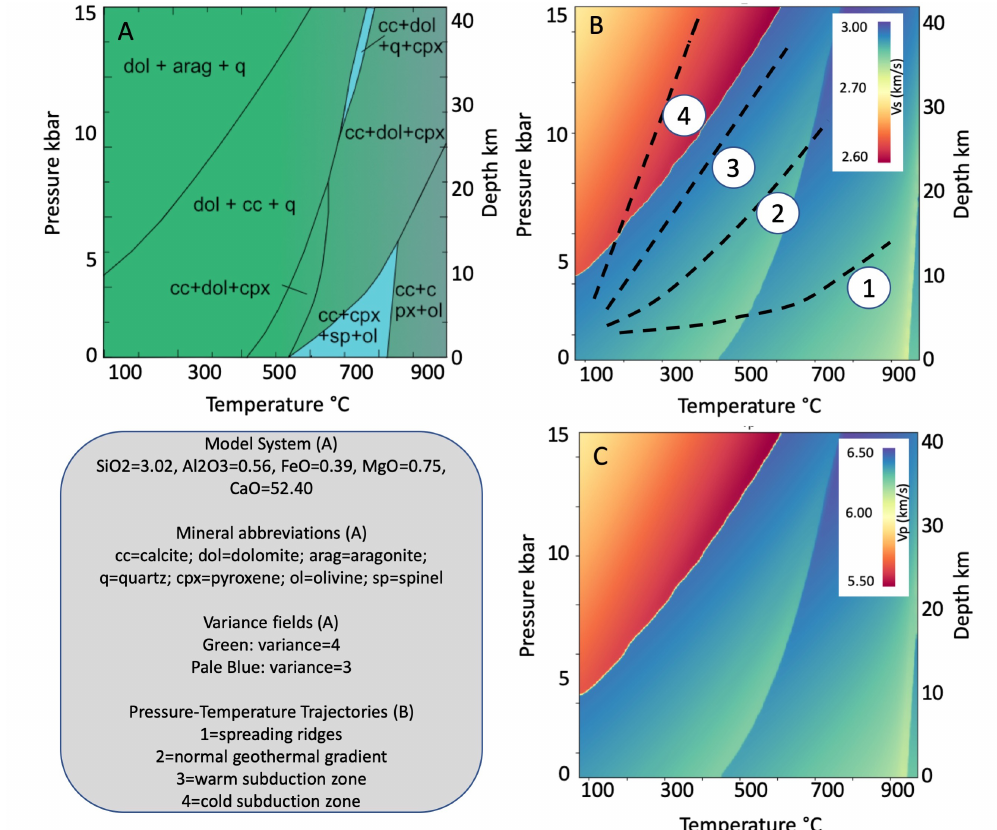
Figure 8. ( A ) Pseudosection calculated using Perple _ X thermodynamic packages [85]. ( B ) Vs (km/s) seismic waves contour diagram. ( C ) Vp (km/s) seismic waves contour diagram. Geothermal gradients in B after Cloos (1993)